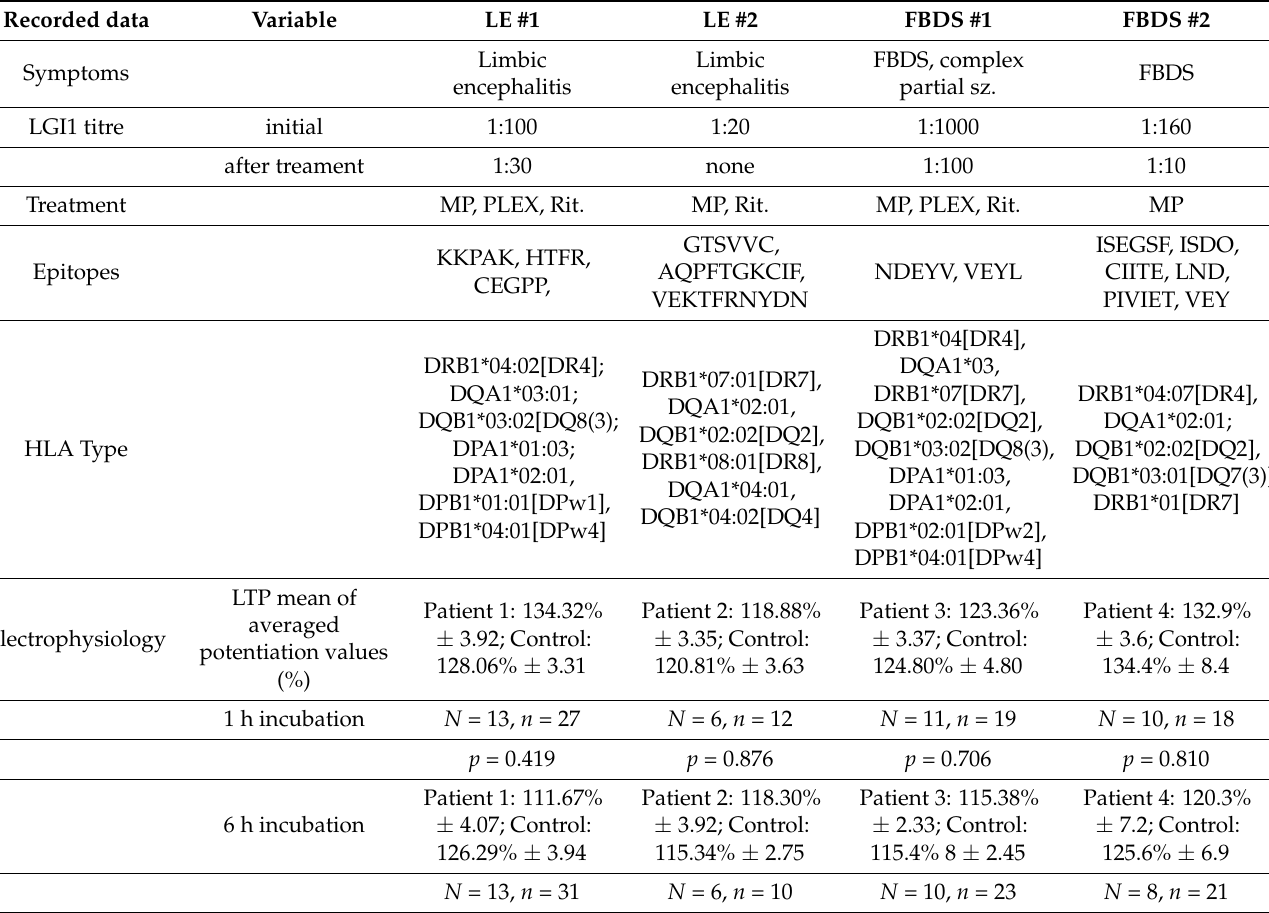
Table 1. Synopsis of patients’ characteristics and the results from the electrophysiological recordings, spine density measurements, epitope mapping. Significant results are written in red. (Data presented as mean ± SEM, N = number of animals, n = number of recorded slices or analyzed dendrites, p -value as a result of unpaired Students t -test, p <